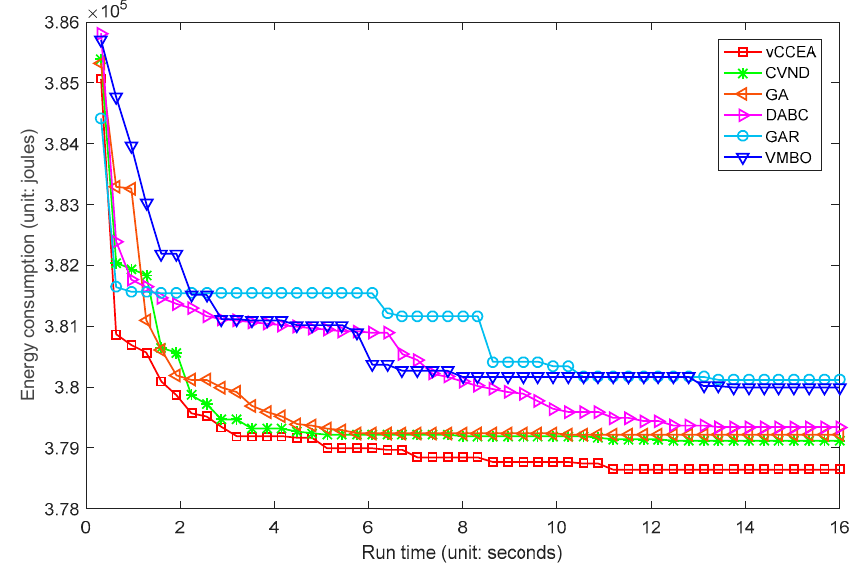
Figure 10. The convergence curve for instances of 40 × 5.